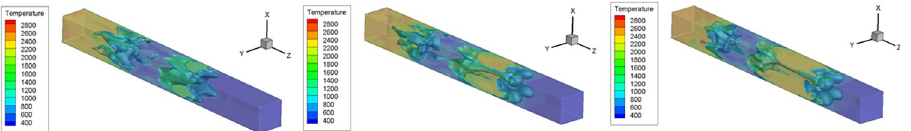
Fig 22. Temperature isosurface at different gas concentrations at 70 ms (5%; 9.5%; 16%).